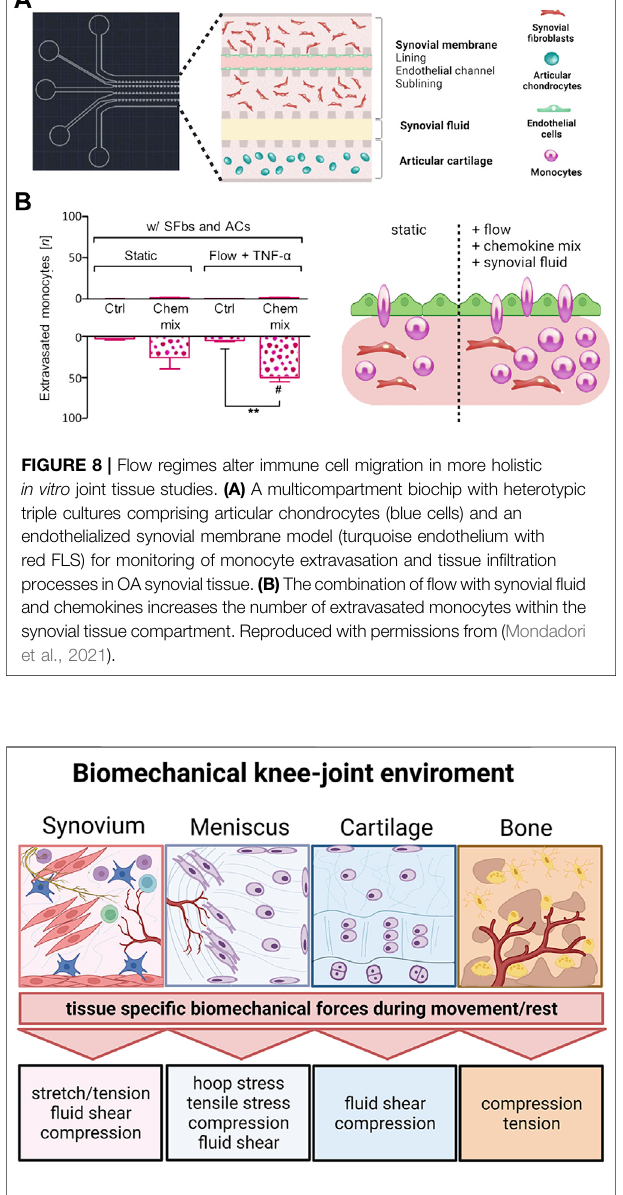
FIGURE9| Thebiomechanicalknee-jointenvironmentmatters.Synovial joints comprise a very diverse set of heterotypic tissue architectures including the synovium, meniscus, cartilage, and subchondral bone. Similar to their architecture, the respective biomechanical microenvironment during joint movement is tissue-speci fi c and comprises distinct biomechanical principles. Created with permissions from Biorender.com.